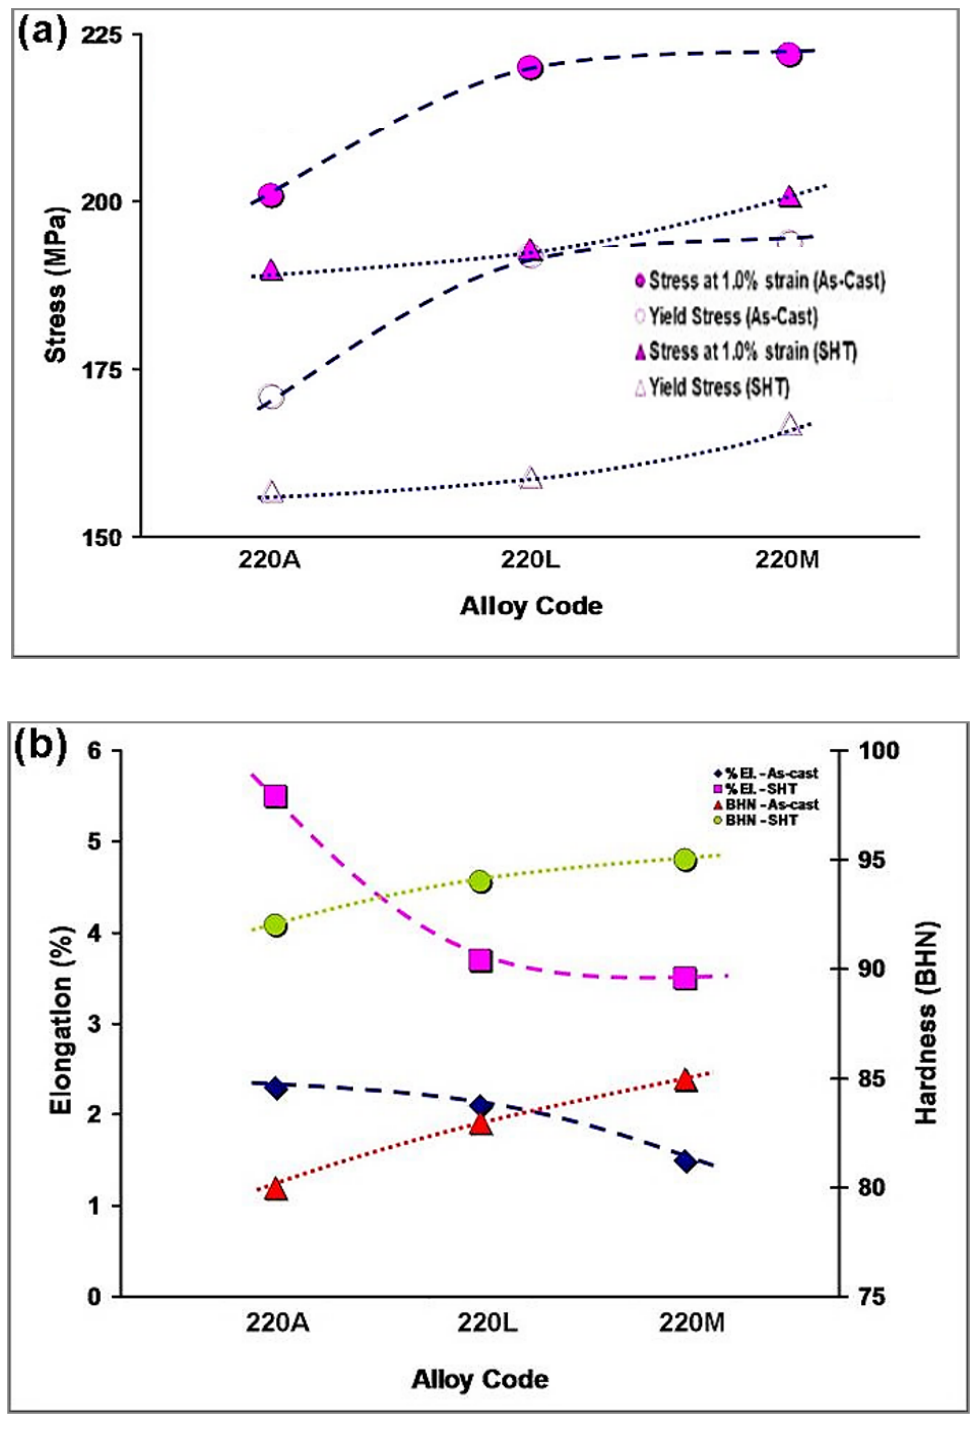
Figure 6. ( a ) Tensile stress (at 1.0% strain) and yield stress and ( b ) percent elongation and Brinell hardness in the as-cast and solution heat-treated (SHT) conditions.